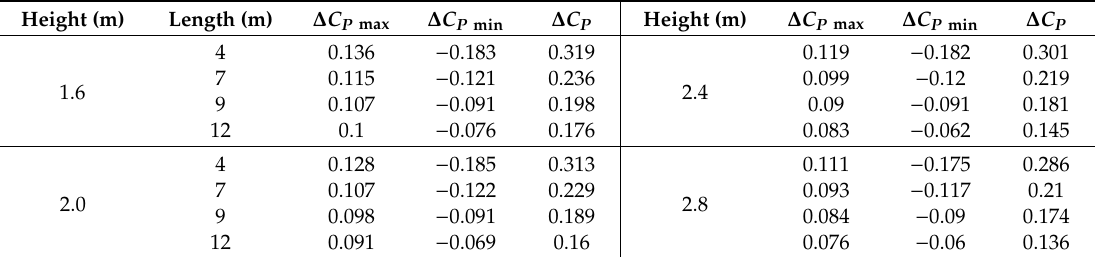
Table 2. ∆ Cp max, ∆ Cp min, and ∆ Cp at di ff erent heights with di ff erent nose lengths.